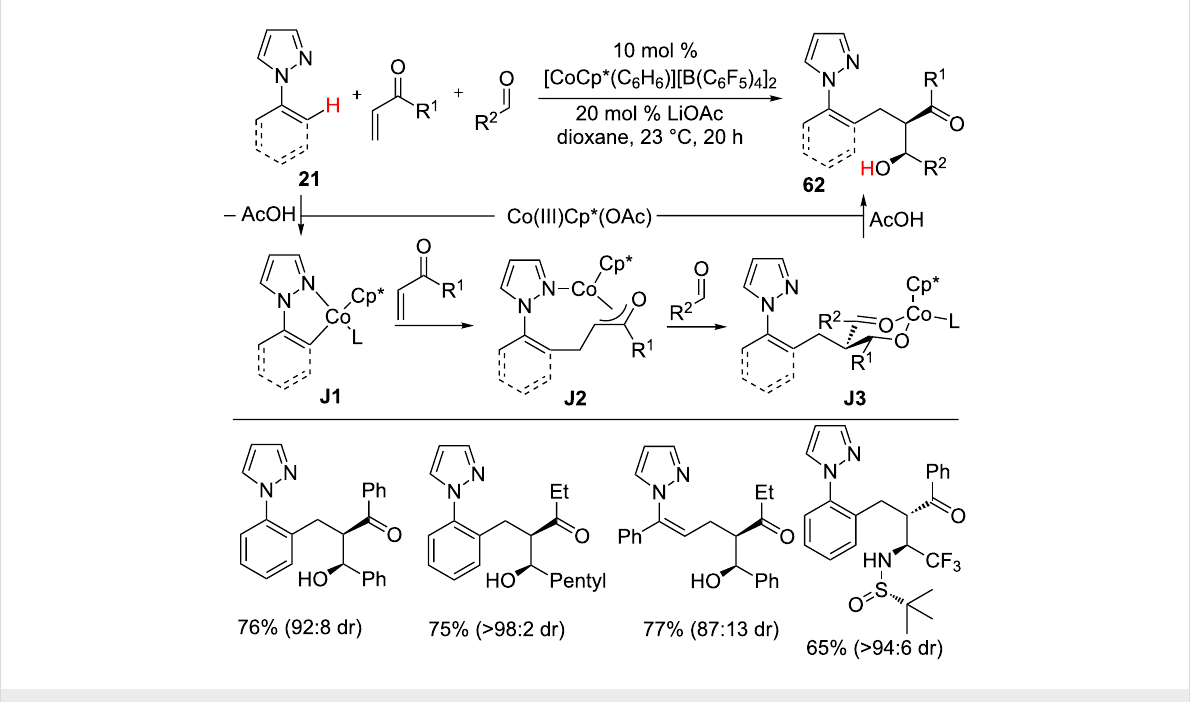
Scheme 39: Co(III)-catalyzed three-component coupling.